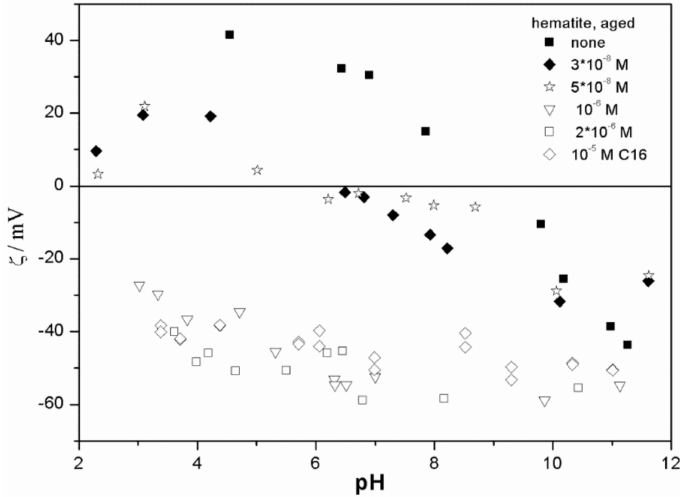
Figure 2. The ζ potential of hematite in aged dispersions in the presence of sodium hexadecylsulfate.